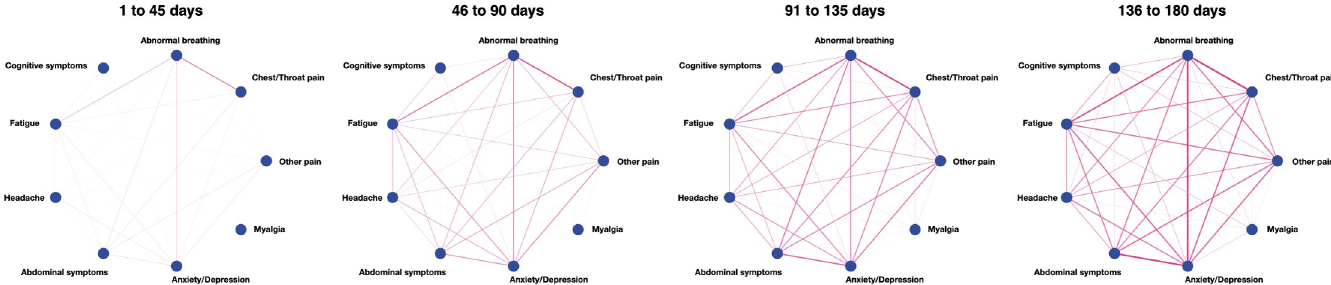
Fig 4. The long-COVID network emerges over the 6-month period, with an increase in the average degree over time. See text for details and Fig E in S1 Fig for a finer grained visualization (10-day intervals).